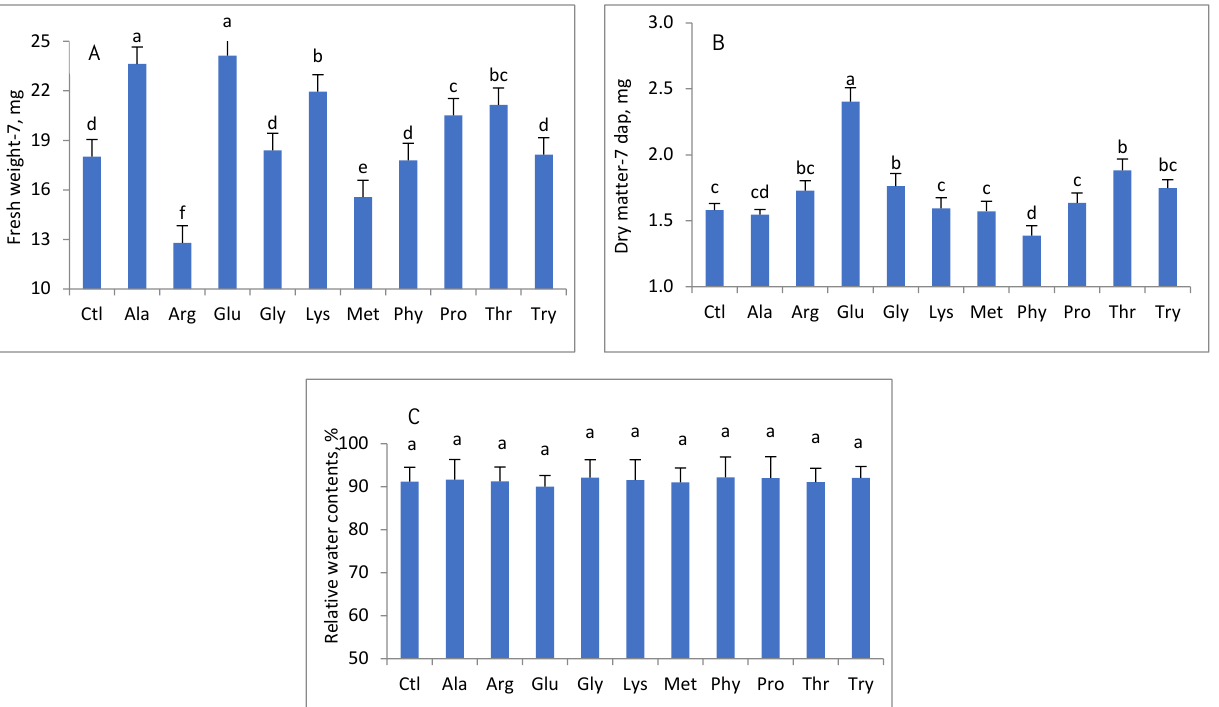
Figure 4. Effect of priming onion seeds with amino acids. ( A )—Fresh weight-7, mg; ( B )—Dry matter-7, mg; ( C )—Relative water contents-7, %. Ctl (Control); Ala (Alanine); Arg (Arginine); Glu (Glutamine); Gly (Glycine); Lys (Lysine); Met (Methionine); Phy (Phenylalanine); Pro (Proline); Thr (threonine); Try (tryptophan). Columns that share the same letter(s) are not statistically significant at p ≤ 0.01.